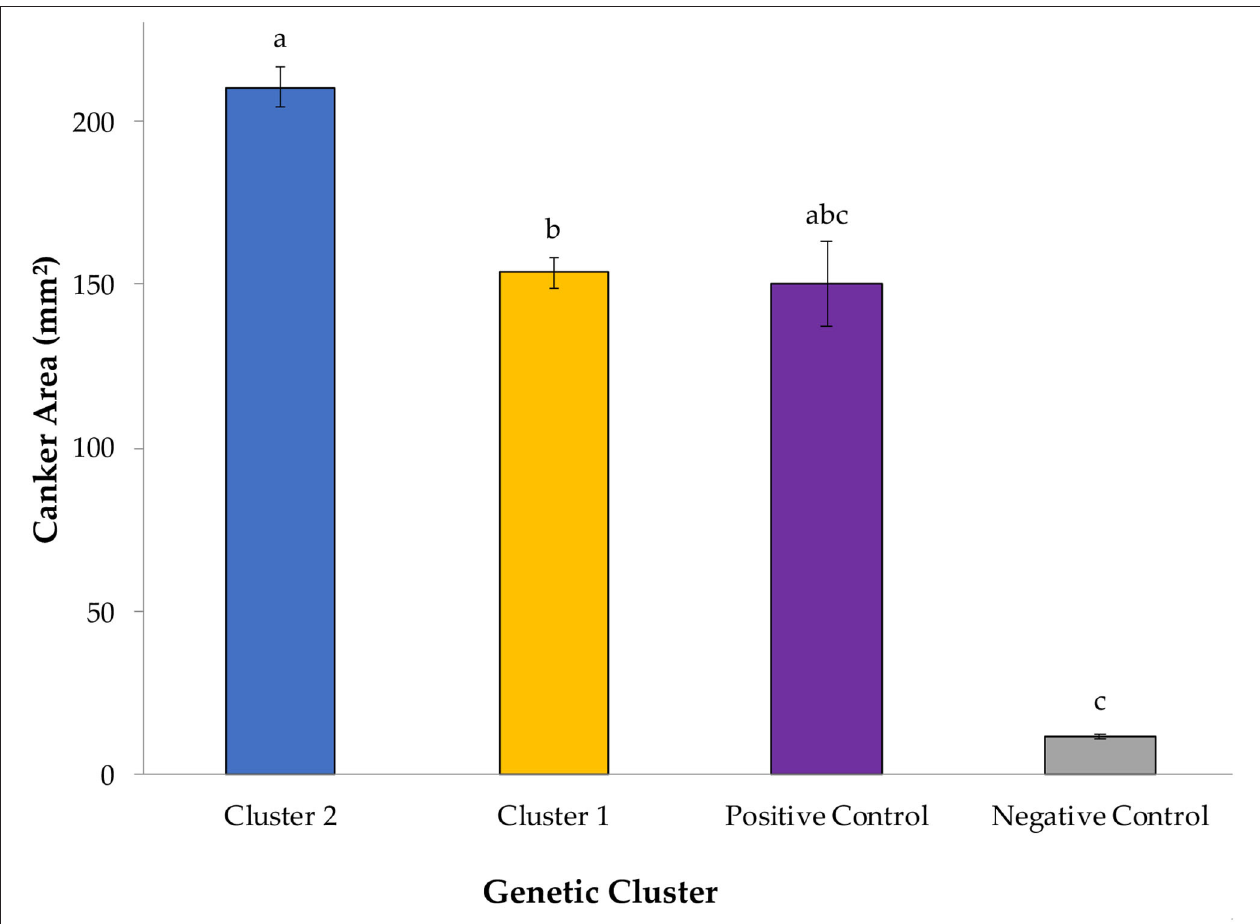
FIGURE 1 | Mean canker sizes were observed at 7 days after inoculation (DAI) with Geosmithia morbida isolates representing 2 genetic clusters, as were characterized in the studies by Hadziabdic et al. (2014) and Hadziabdic et al. (unpublished data, Supplementary Figure S1 ). In this study, 12 G. morbida isolates represented genetic cluster 1 and 13 G. morbida isolates represented genetic cluster 2. Within cluster or control group, treatment mean separations were made using least square mean estimates calculated from rank-transformed canker areas and differ significantly ( P < 0.05; Tukey’s honestly significant difference) when indicated with different letters. Mean canker areas and standard errors of genetic clusters and controls depicted here reflect non-transformed data measured across assays performed on both assayed trees.